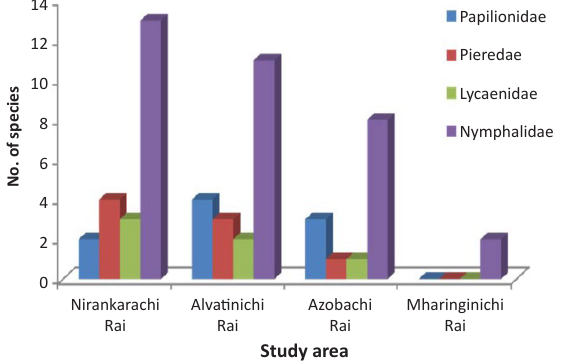
Figure 2. Family wise distribution of butterfly species in four sacred groves of Goa